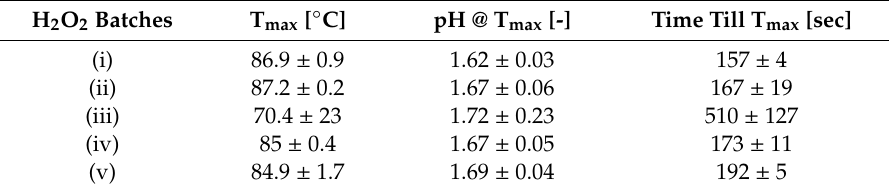
Table 3. The reaction di ff erences for the five batches of hydrogen peroxide when using 100 mL